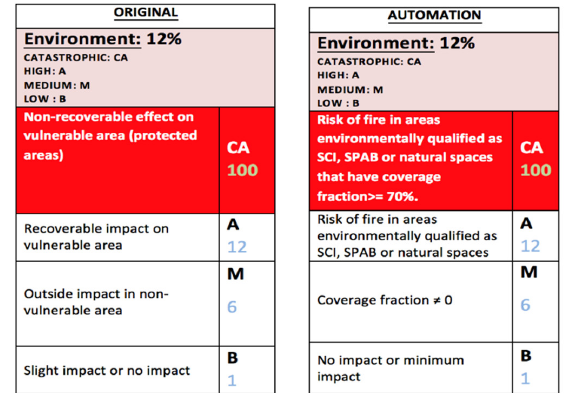
Figure 13. Environment criteria effects conversion (with GIS Data).